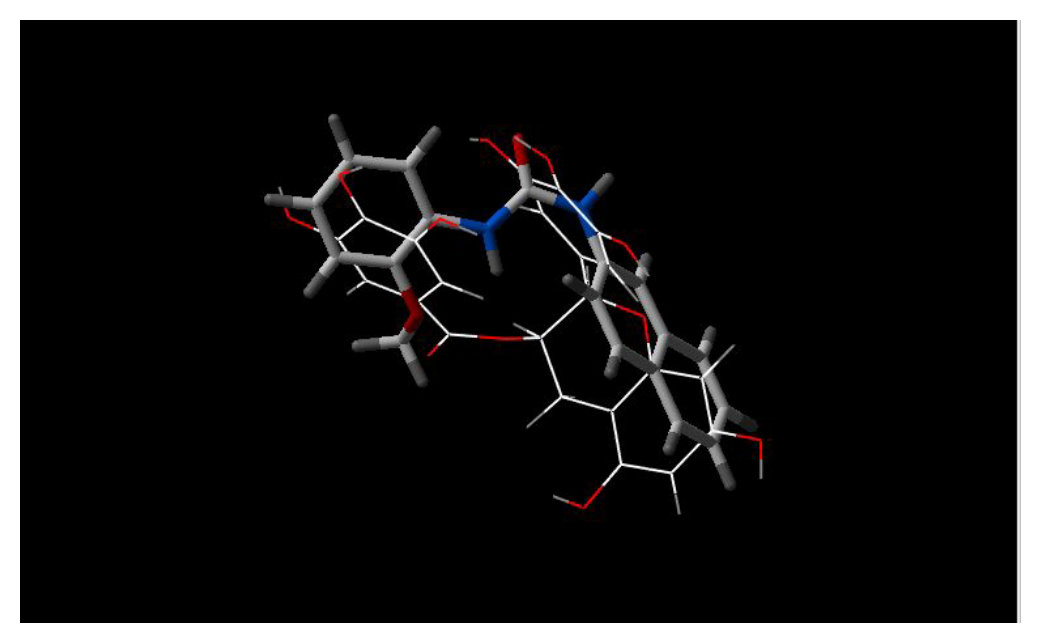
Figure 7. Best fit of optimised INF271 (sticks) and Epigallocatechin-3-O-gallate (wireframe)